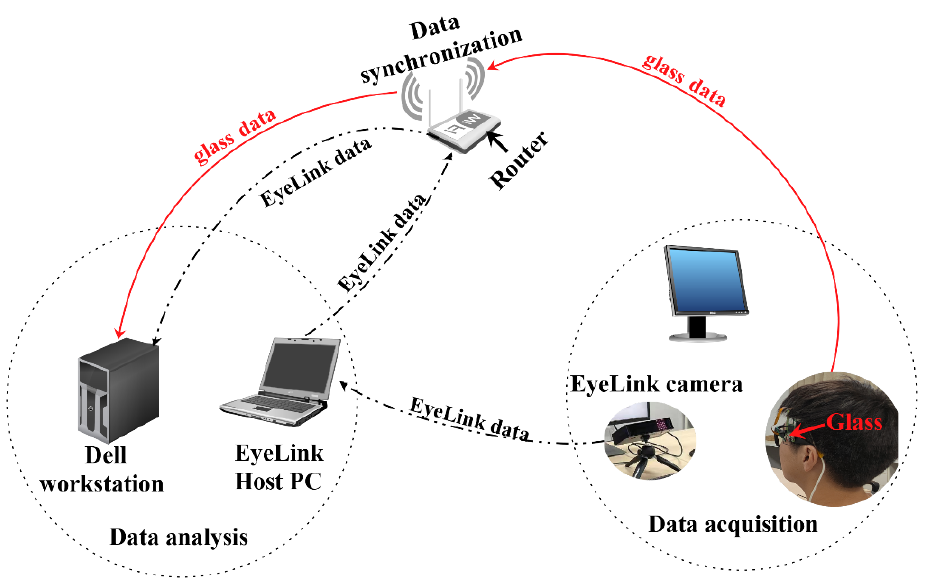
Figure 7. The testing setup used to validate the glass prototype and the LGN network.